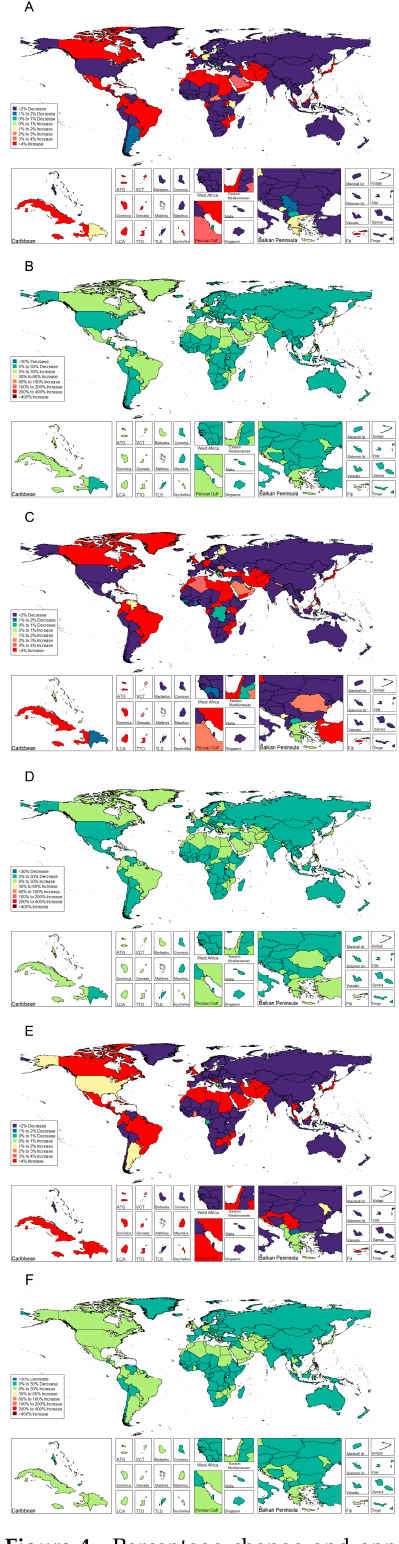
Figure 4. Percentage change and annual percentage change of disability adjusted life years of urolithiasis stratified by gender and 195 Countries and territories. ( A ) PC of DALYs stratified 195 Countries and territories of both gender; ( B ) APC of DALYs stratified 195 Countries and territories of both gender; ( C ) PC of DALYs stratified 195 Countries and territories of male; ( D ) APC of DALYs stratified 195 Countries and territories of male; ( E ) PC of DALYs stratified 195 Countries and territories of female; ( F ) APC of DALYs stratified 195 Countries and territories of